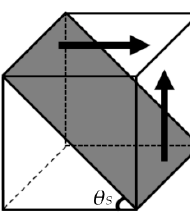
Figure 5. Fracture angle of cast iron under pure shear, θ S = 45° [8].